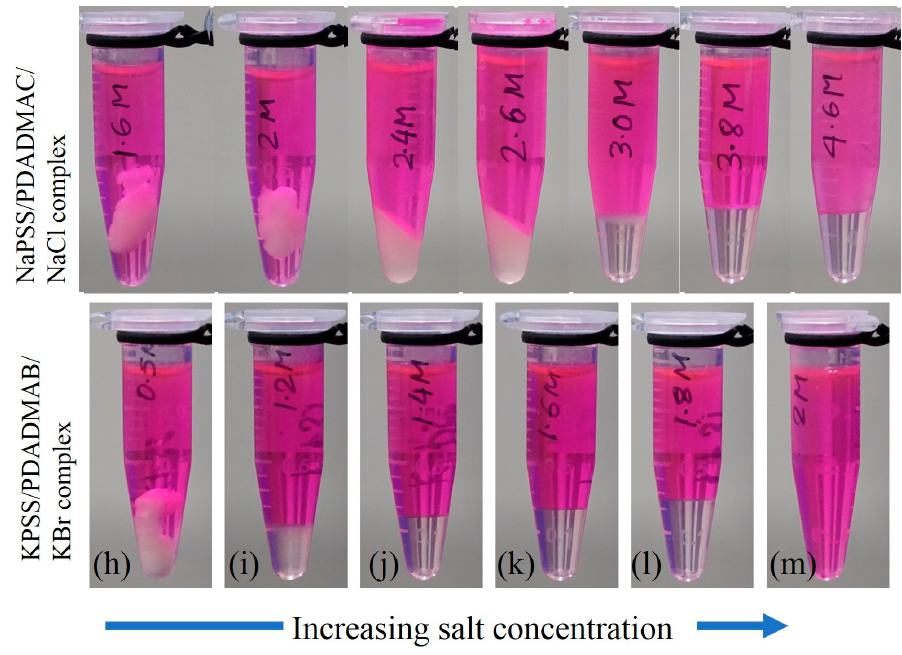
Figure 1. Photographs of complexes obtained after centrifugation for polyelectrolyte combinations of ( a – g ) NaPSS/PDADMAC for several concentrations of NaCl, ( h – l ) KPSS/PDADMAB at several concentrations of KBr with ( m ) uniform solution at 2 M KBr. Rhodamine-B dye was added to the supernatant to show the interface between supernatant at the top and complexes at the bottom in the microcuvettes. NaPSS: sodium poly(styrene sulfonate); PDADMAC: poly(diallyl dimethyl ammonium chloride); KPSS: potassium poly(styrene sulfonate) /PDADMAB: poly(diallyl dimethyl ammonium bromide) .